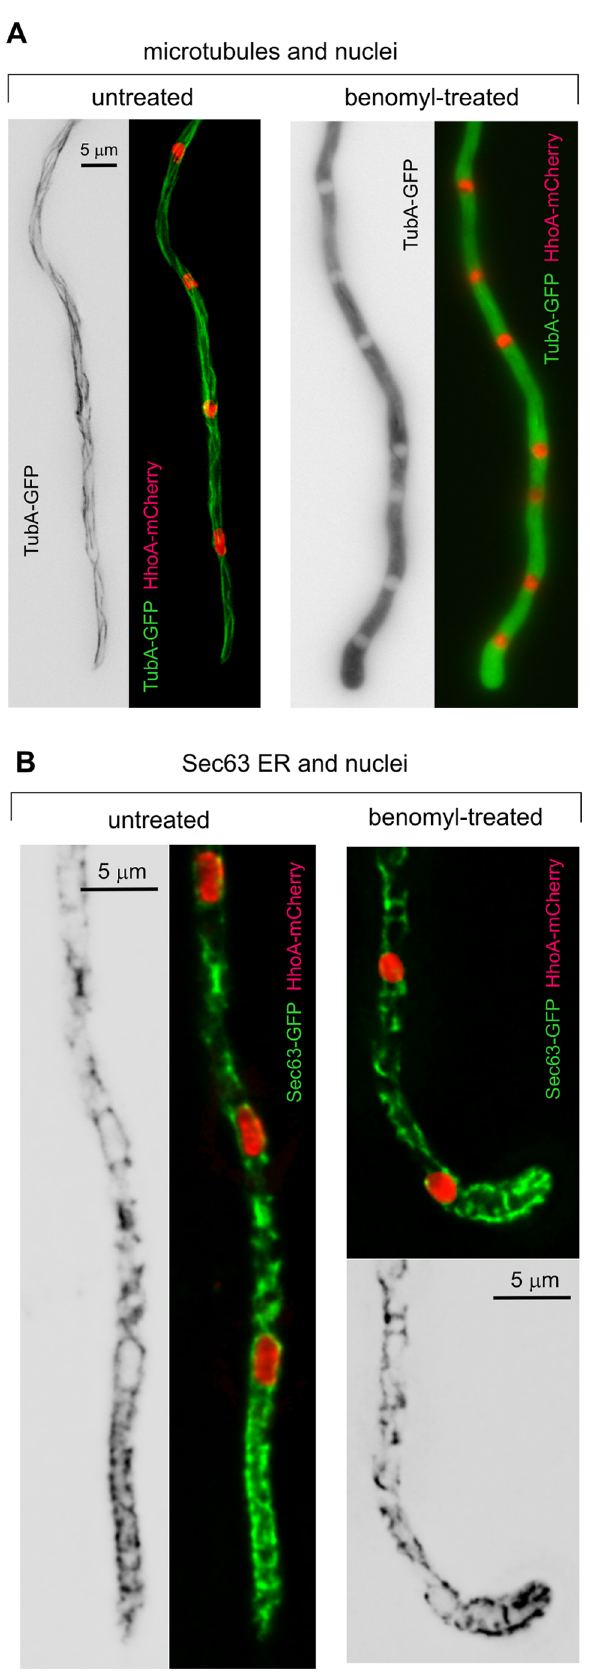
Figure 3. The ER does not undergo major changes following microtubule depolymerization. A. Control experiment demonstrat- ing the depolymerization of MTs (green) upon treatment with benomyl. Unpolymerized TubA-GFP accumulates in the cytosol, leaving the nuclei empty (nuclei are labeled with HhoA-mCherry). The picture was taken after after 17 min of incubation in the presence of the drug. B. Effect of benomyl treatment on the Sec63-GFP-labeled ER. The representative example shown on the right corresponds to a cell incubated for 30 min in the presence of benomyl. The positions of the nuclei are revealed by the HhoA-mCherry